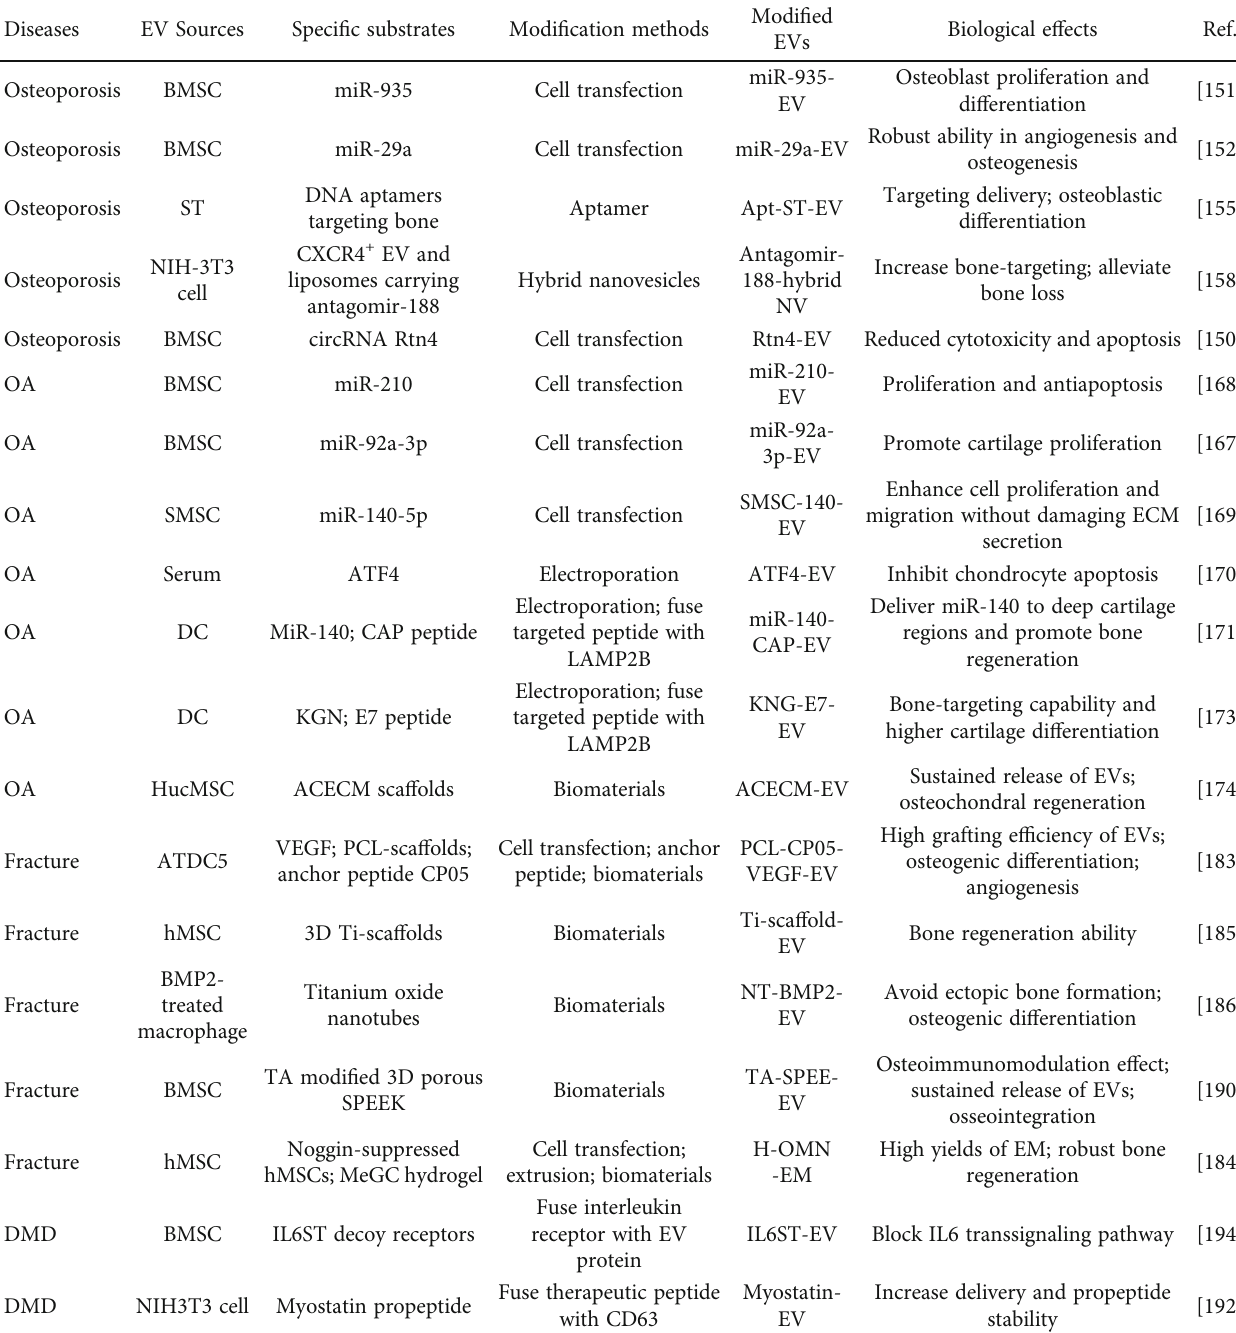
Table 8: Modi fi ed EVs in the therapy of musculoskeletal